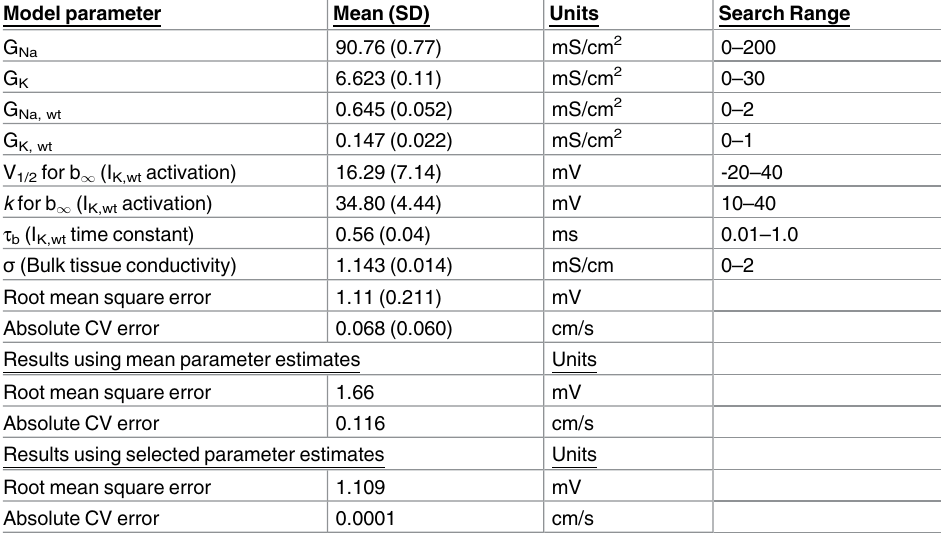
Table 1. Model optimization via genetic search algorithm (n = 9 runs).